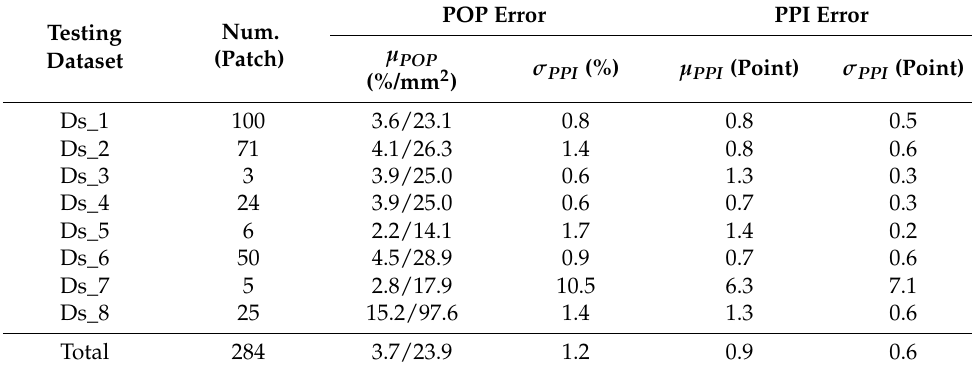
Table 2. POP and PPI mean error and error standard deviation